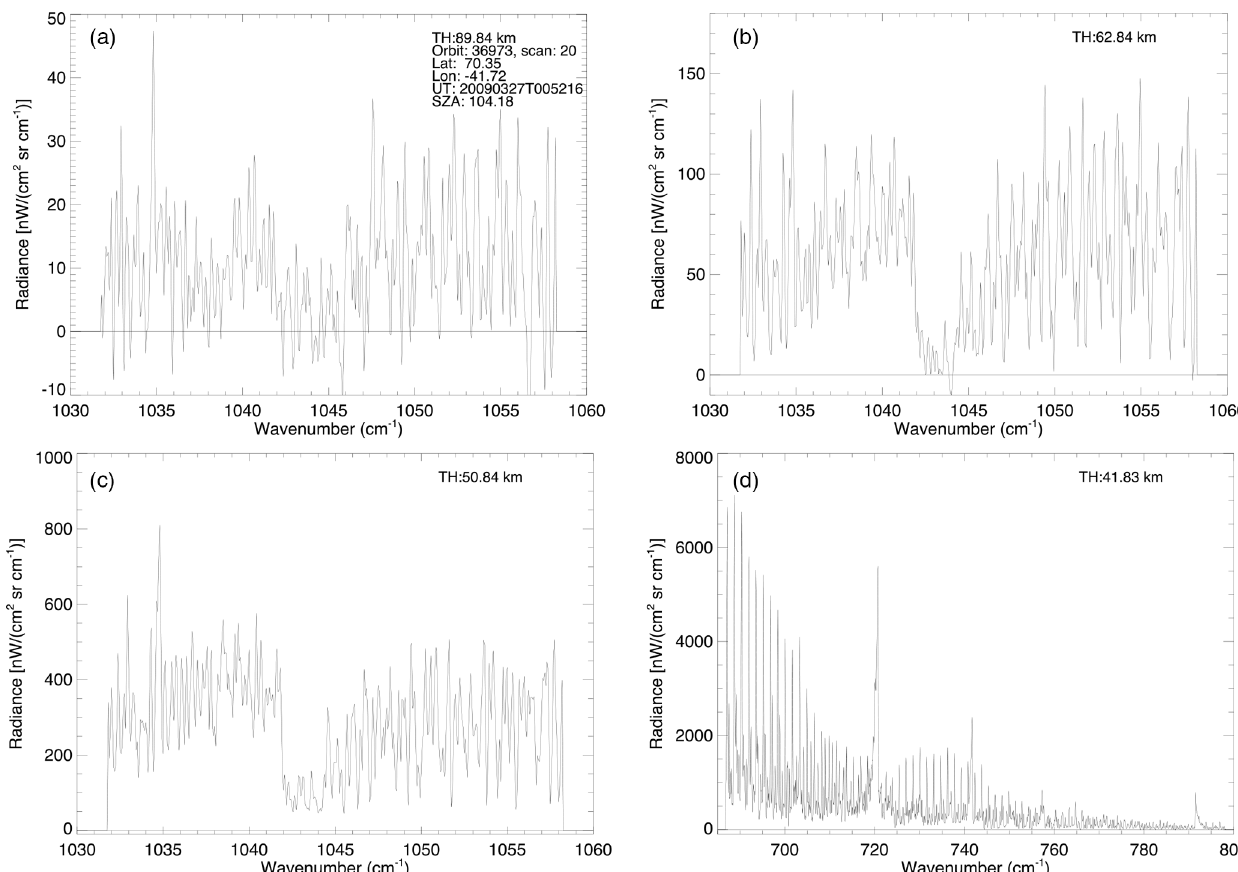
Figure 2. Examples of MIPAS L1b apodized single spectra in channel A (d) and in channel AB (a–c) at several tangent heights (as labelled) used in the inversion of O 3 . The geolocation of the spectra is given in panel (a) . The radiance in the 1030–1060cm 1 spectral region is dominated by O 3 features. However, in channel A (d) , it is dominated by CO 2 emissions and the O 3 contribution is hardly noticed.